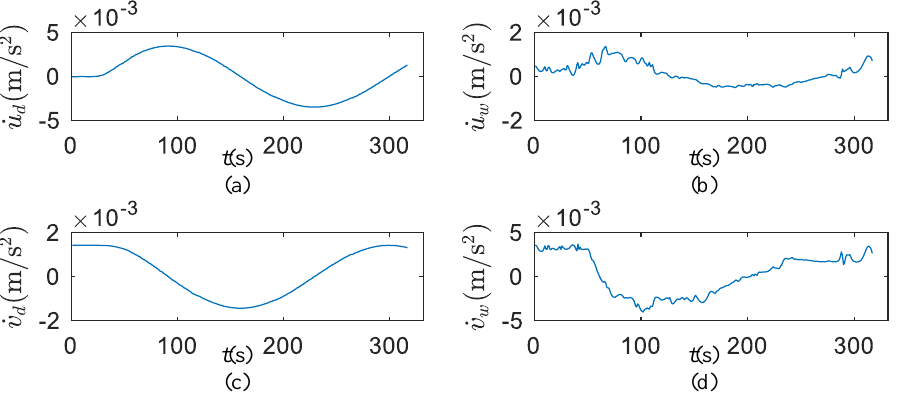
Figure 7. Wind- and wave-induced accelerations of +20° turning circle test. ( a ) Surge acceleration induced by wave; ( b ) surge acceleration induced by wind; ( c ) sway acceleration induced by wave; ( d ) sway acceleration induced by wind.